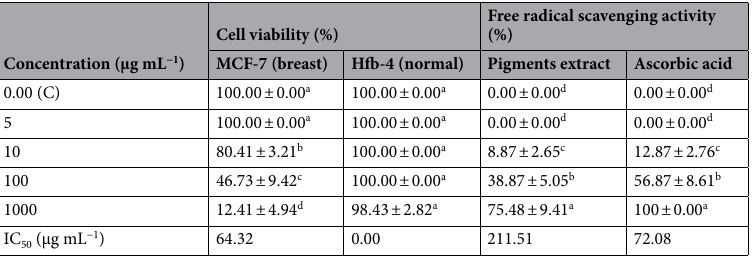
Table 3. Cytotoxic and antioxidant activities of the crude pigment extracted from SSF cultures of M. ruber SRZ112 grown on potato peel. Calculated mean is for triplicate measurements from two independent experiments ± SD, a–d Means with different superscripts in the same column are considered statistically different (LSD test, P ≤